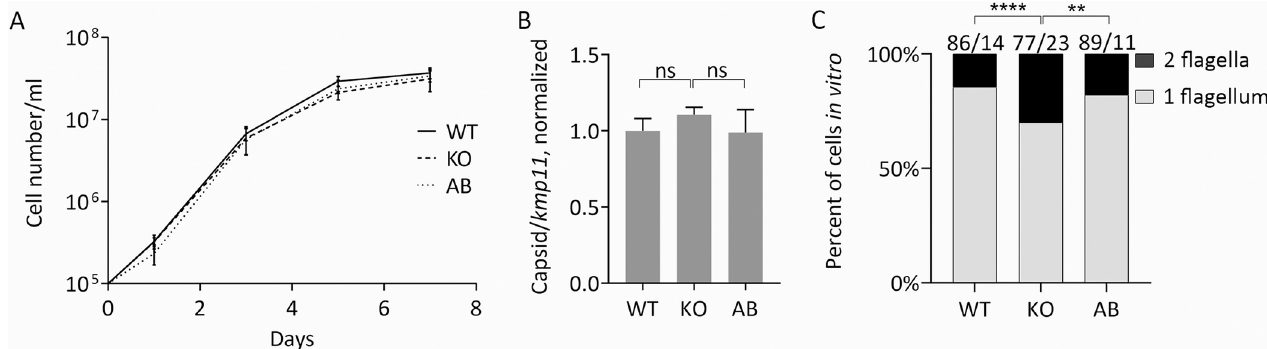
Fig 4. Growth curve, analysis of viral load, and bi-flagellated state of L . guyanensis with ablated Lg PAP2L in vitro . A) Growth curves of the WT, KO, and AB L . guyanensis . (B) RT-qPCR analysis of the LRV1 capsid RNA level in the WT, KO, and AB L . guyanensis after 5 days of cultivation. Data are presented as normalized fold expression over kmp11 and reported as the mean and standard deviation of three replicates. Two-tailed Student’s t-test was used for statistical analysis; ns–not significant. (C) The proportion of mono- and bi-flagellated cells in the WT, KO, and AB L . guyanensis after 5 days of cultivation. Asterisks indicate significant differences ( �� – P � 0.01; ���� – P �